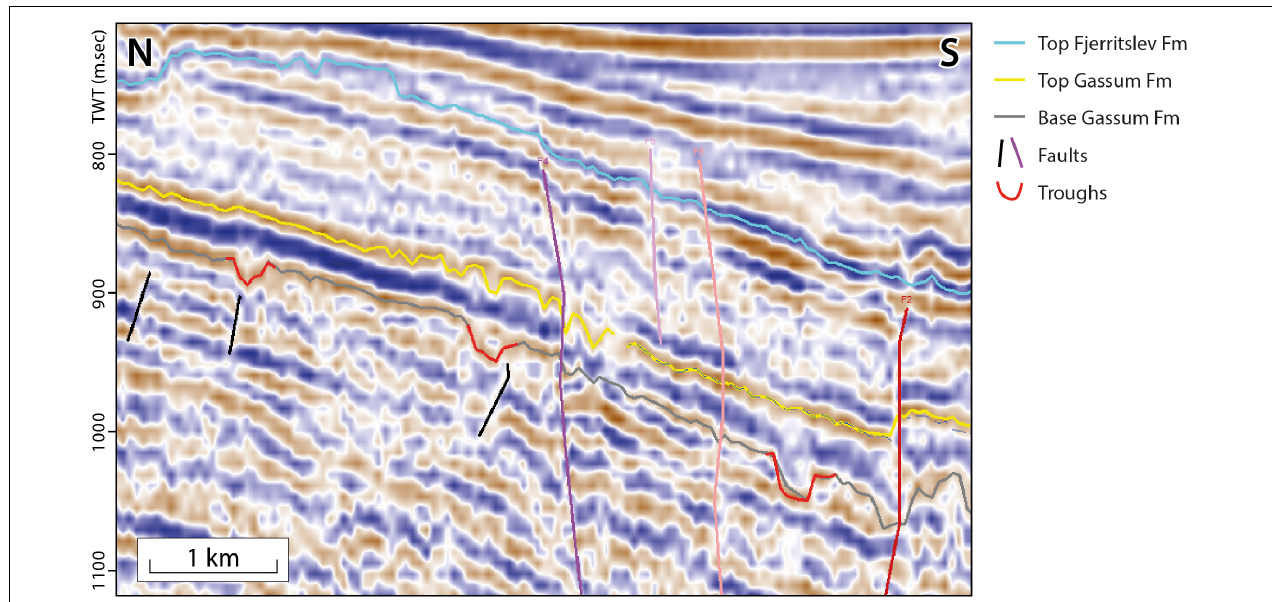
FIGURE 5 | Examples of seismic troughs, which are common in the study area and represent possible channel structures. The figure presents a close-up of the northern end of Figure 2 .